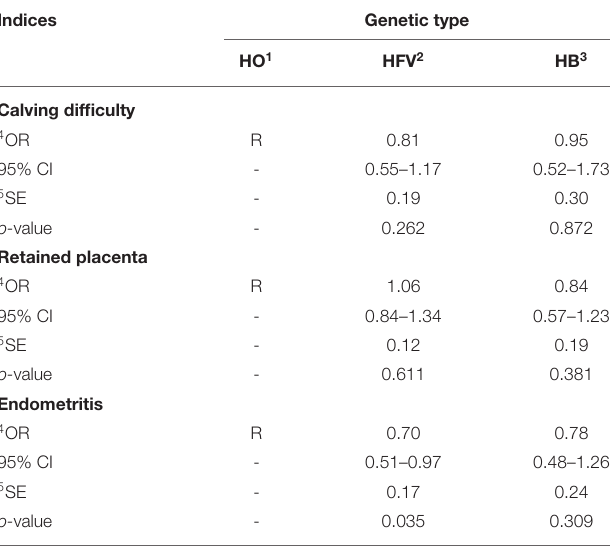
TABLE 4 | Odds ratio for reproductive problems of purebred Holstein, Holstein × Fleckvieh, and Holstein × Brown Swiss cows. Indices